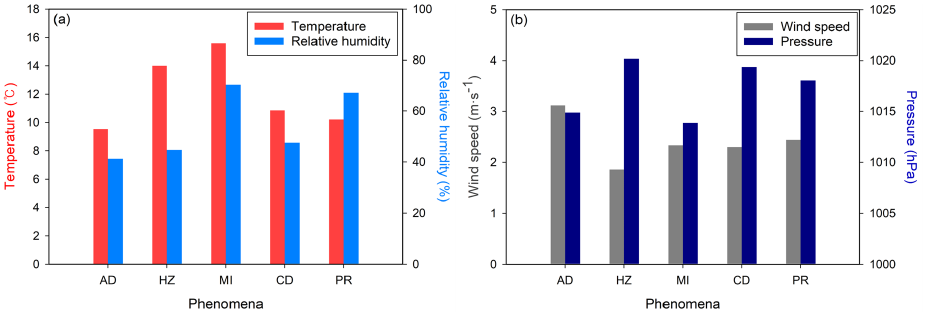
Figure 7. Meteorological factor distributions for each phenomenon: ( a ) temperature and relative humidity, ( b ) pressure and wind speed. AD: Asian dust, HZ: haze, MI: mist, CD: clear days, and PR: precipitation.